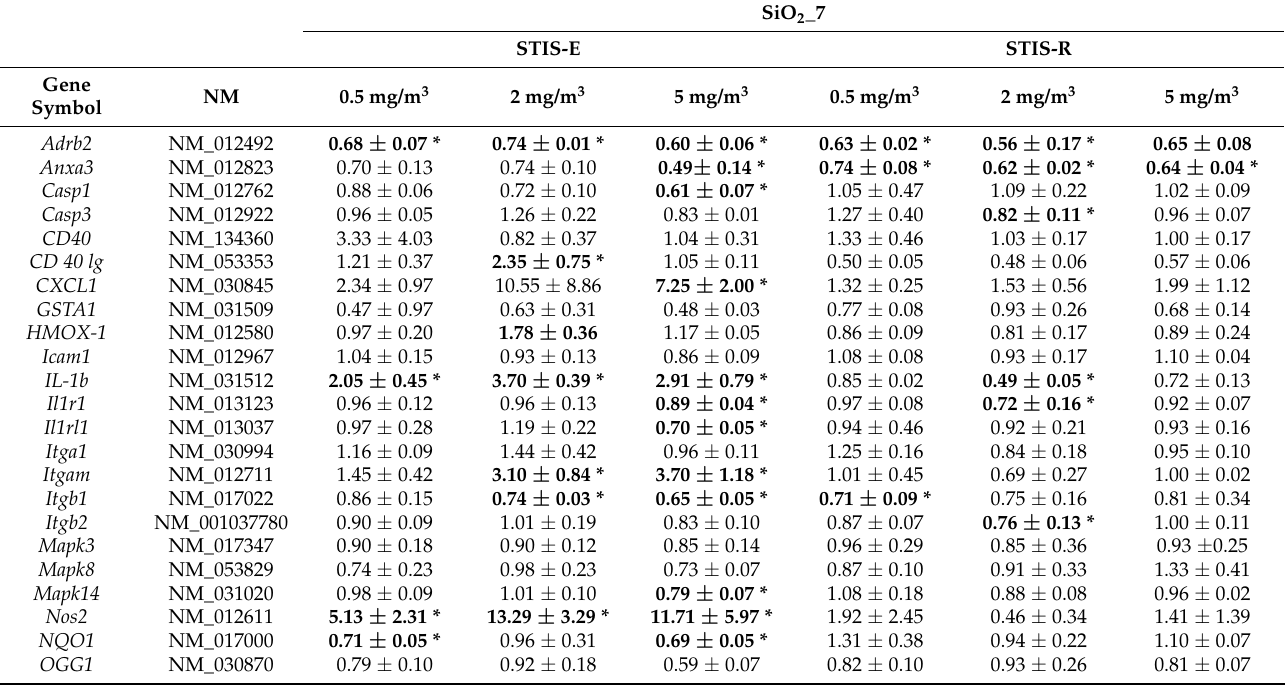
Table 8. Gene expression profile identified by TAC analysis following inhalation of SiO 2 _7 in